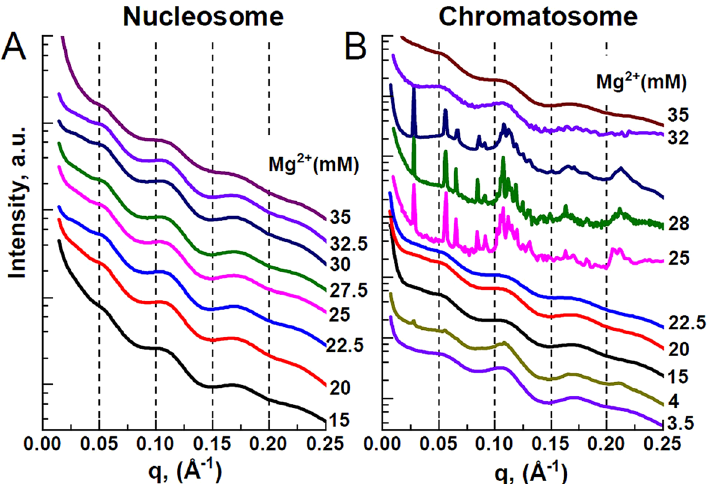
Figure 7. SAXS spectra of the nucleosome ( A ) and chromatosome ( B ) samples precipitated from 8 mg/mL solution by the addition of Mg 2+ . The concentration of Mg 2+ is indicated next to the spectra. In ( B ), the most −1 (see also Fig. S6). The peak at 0.1075 −1 and its prominent peaks are at 0.0278, 0.056, 0.066, and 0.1075 −1 , indicated as q second-order reflection at 0.21 Å Å 1h and q 2h , respectively, originate from chromatosomes stacked into columns. OriginPro software 100 (www.origi nlab.com) was used to create the Å